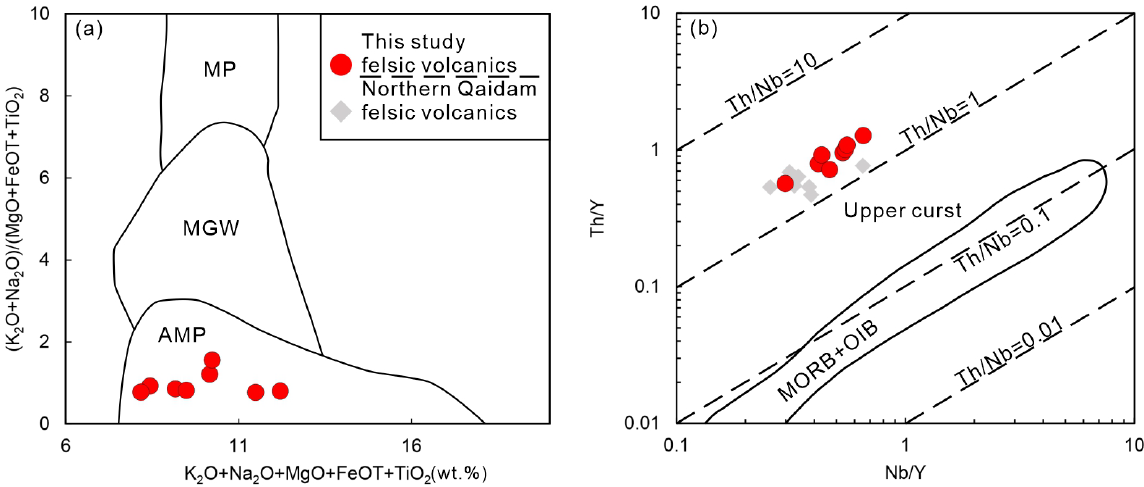
Figure 14. ( a ) K 2 O + Na 2 O + MgO + FeOT + TiO 2 vs. (K 2 O + Na 2 O)/(MgO + FeOT + TiO 2 ) diagram [124] and ( b ) Nb/Y vs. Th/Y diagram [125] for felsic volcanic rocks from the Maoniushan Formation. The data for felsic volcanic rocks in the NQ are from Zhu et al. [123]. AMP-amphibolite; MGW- meta-greywackes; MP - metapelites.